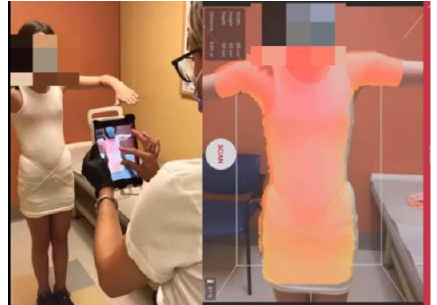
Figure 3. Scanning a patient for a Boston Brace 3D orthosis.